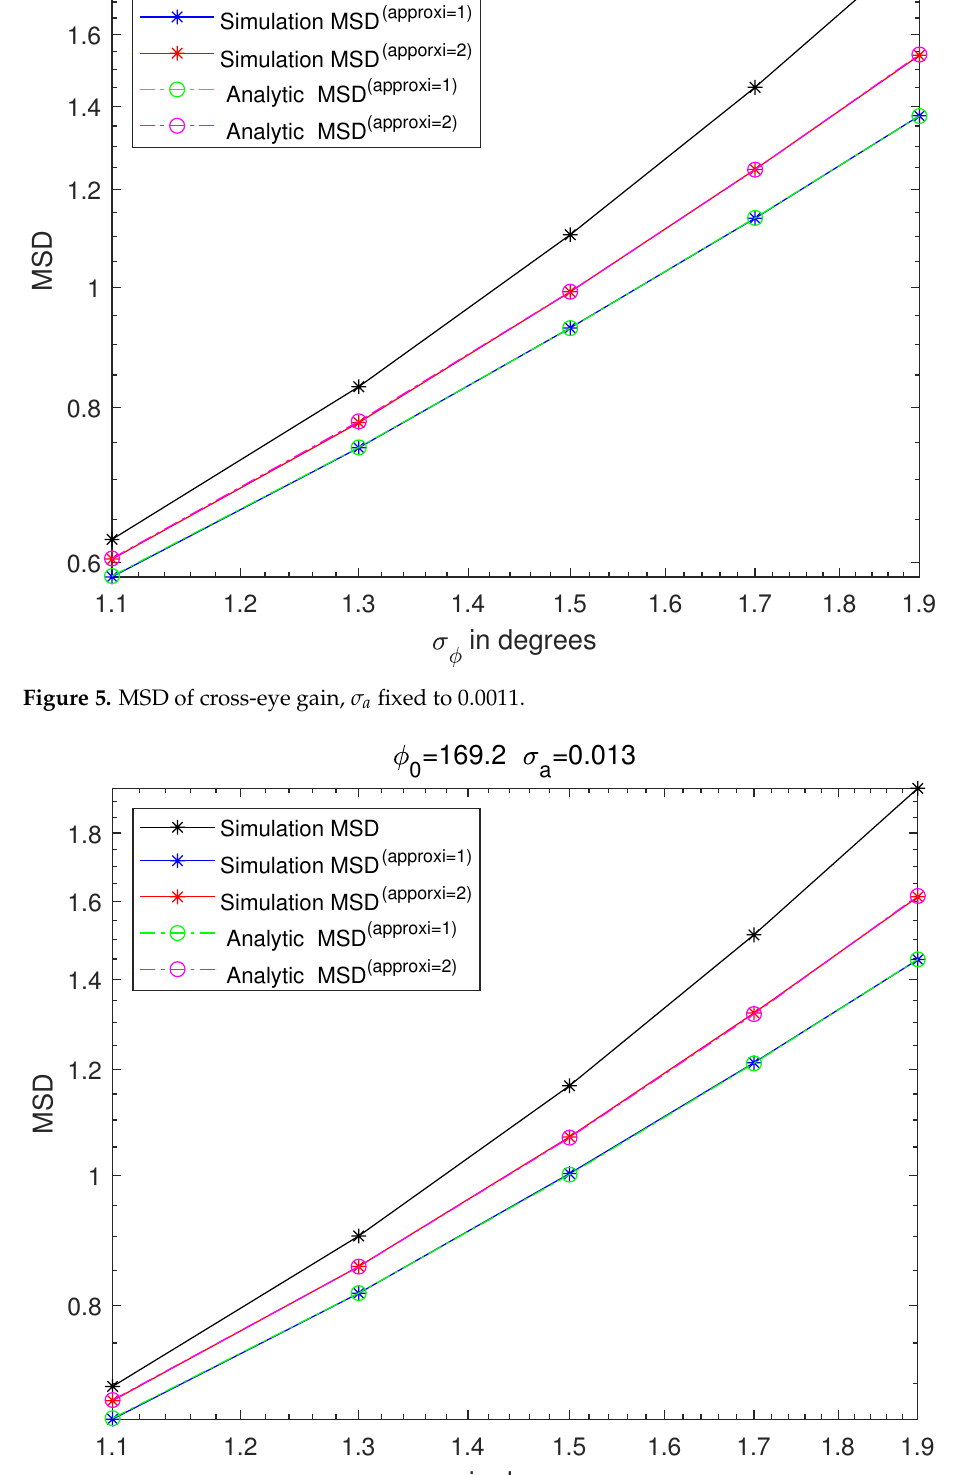
Figure 6. MSD of cross-eye gain, σ a fixed to